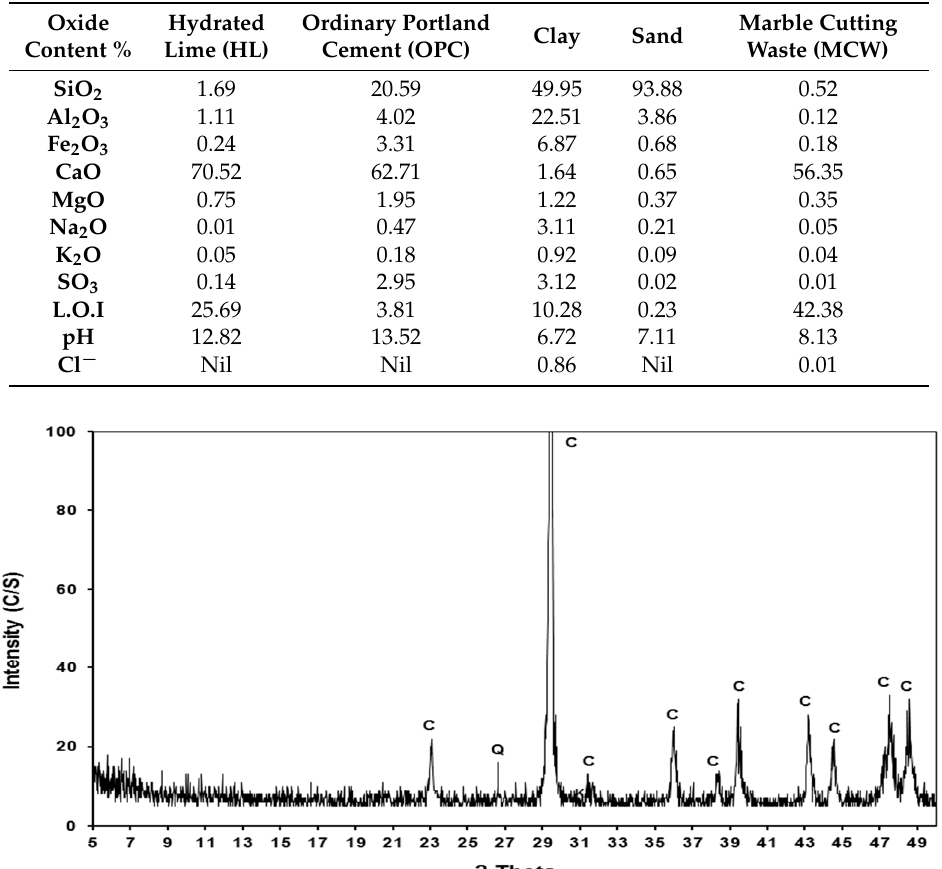
Figure 2. X-ray diffraction (XRD) pattern of the MCW used (C: Calcite, Q: Quartz).